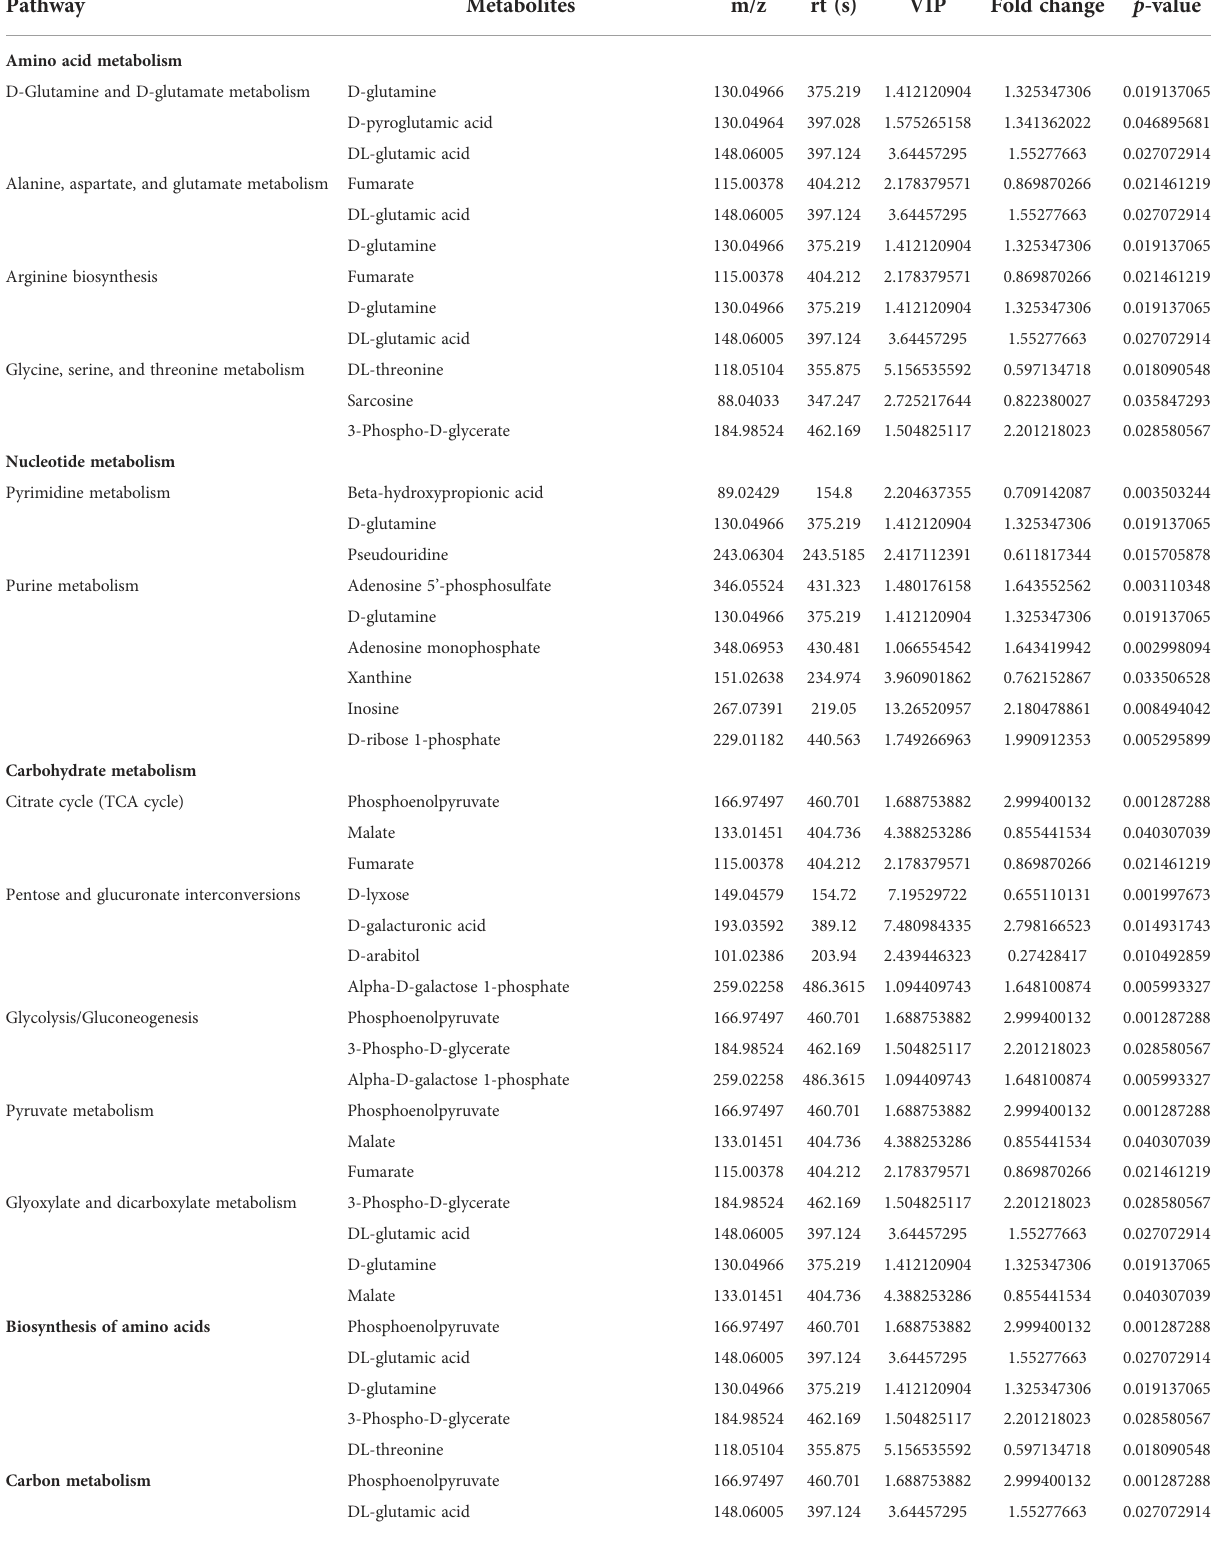
TABLE 1 Altered metabolic pathways and the corresponding differential metabolites in the kidney samples from the young and old groups.